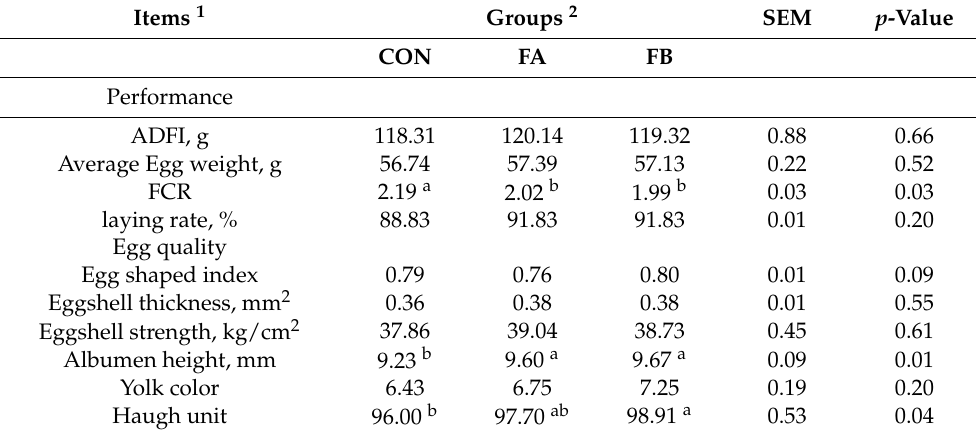
Table 4. Effects of 6% FF on the performance and egg quality of laying hens.